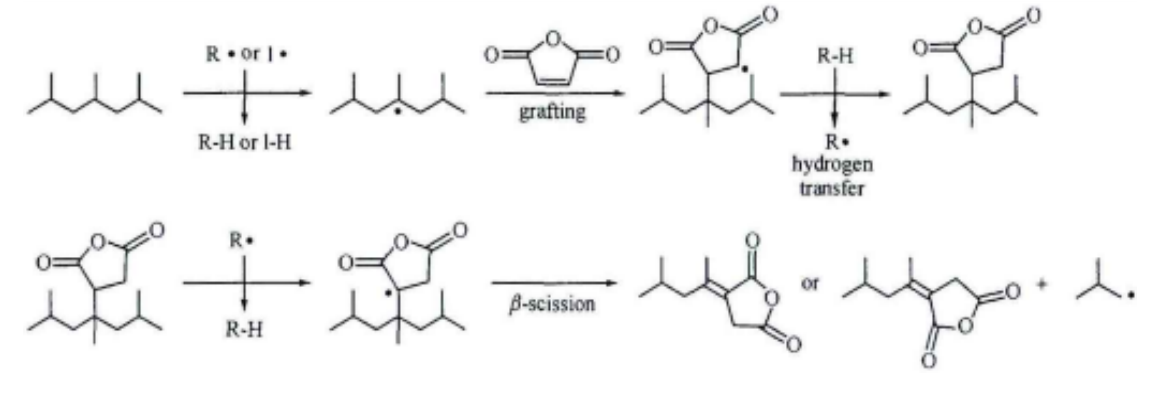
Figure 3. Polypropylene grafting mechanism (2).